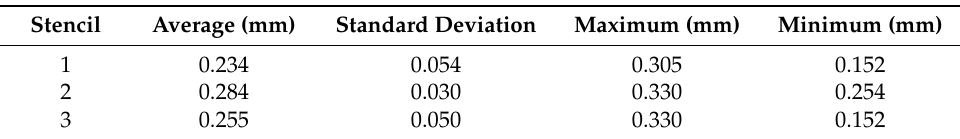
Table 3. Measured Sample